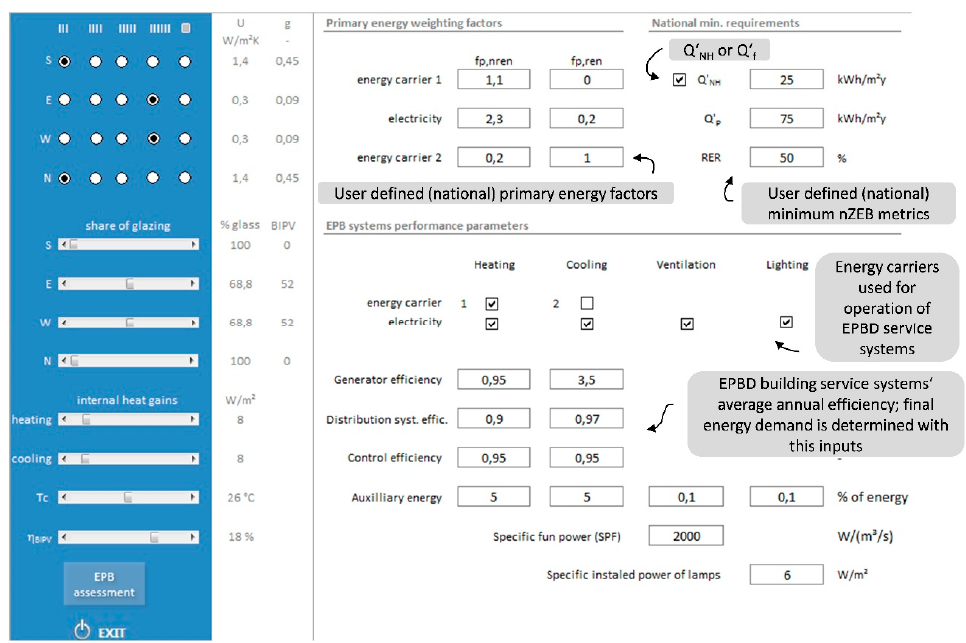
Figure 5. Data GUI for the description of energy carriers, specific national requirements for evaluation of building’s energy e ffi ciency and nZEB metrics, and specifications of Energy Performance of Buildings Directive (EPBD) building service systems.